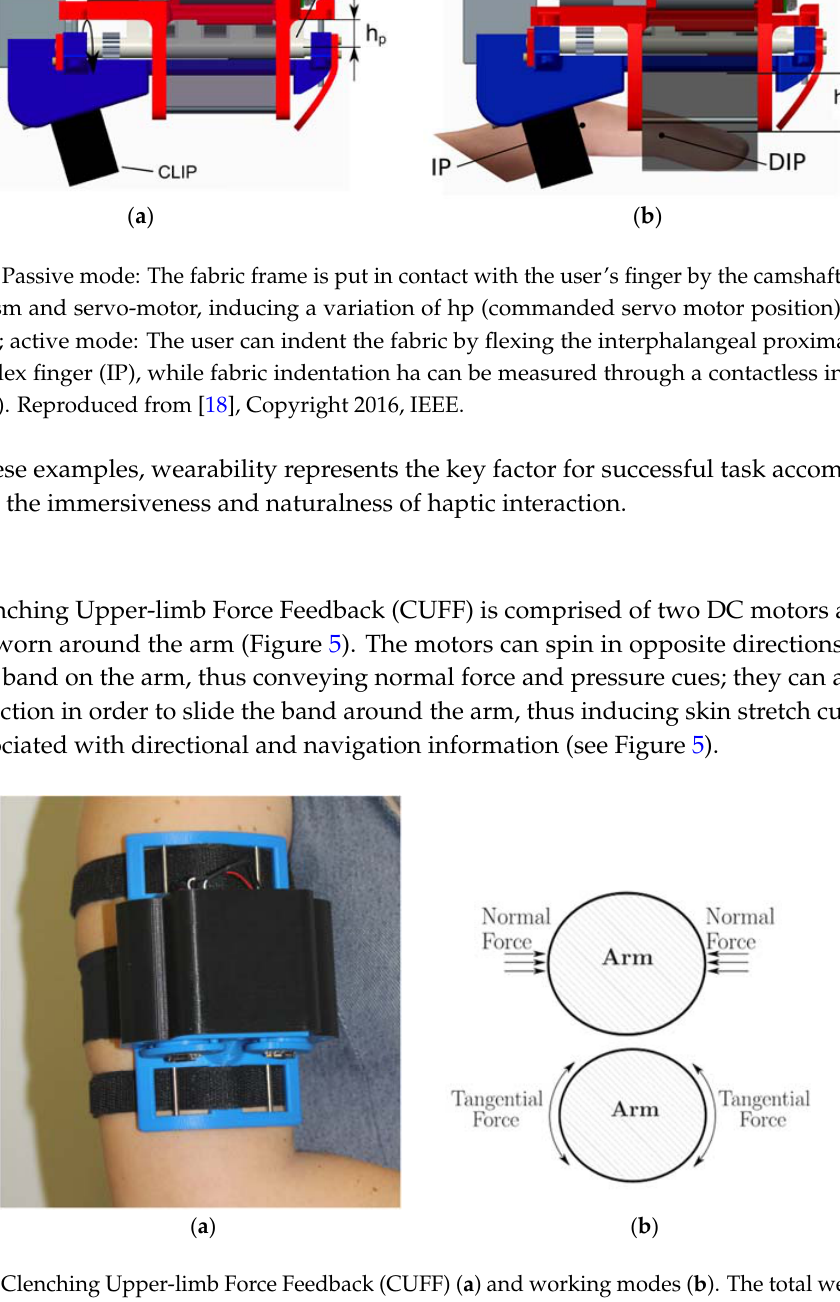
is 494 g and its overall dimensions are 14.5 × 9.7 × 11.6 cm. Reproduced from [14], Copyright 2013,